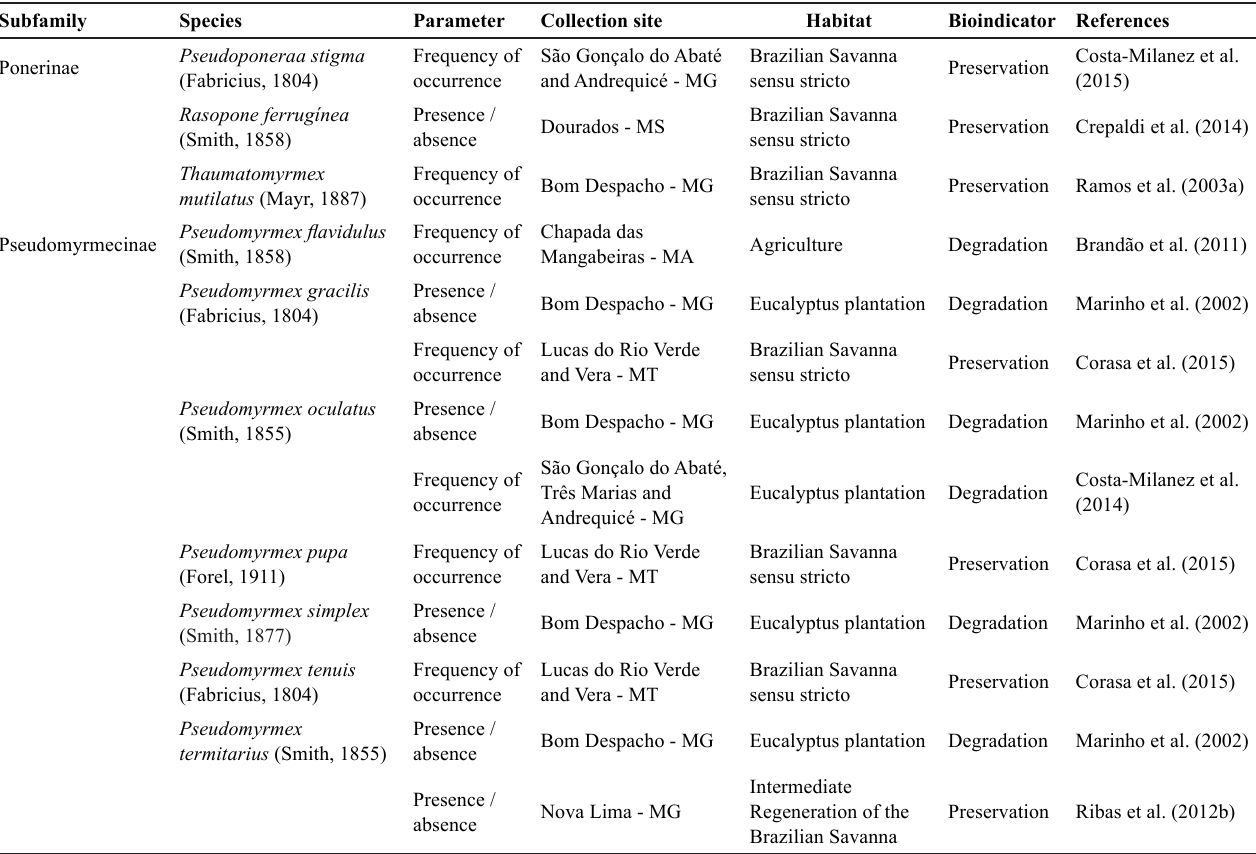
Table 3. Species of ants defined as bioindicators for preservation or degradation in the reference studys, indicating the parameter used to relate to the habitat type, and the reference of the papers analyzed.